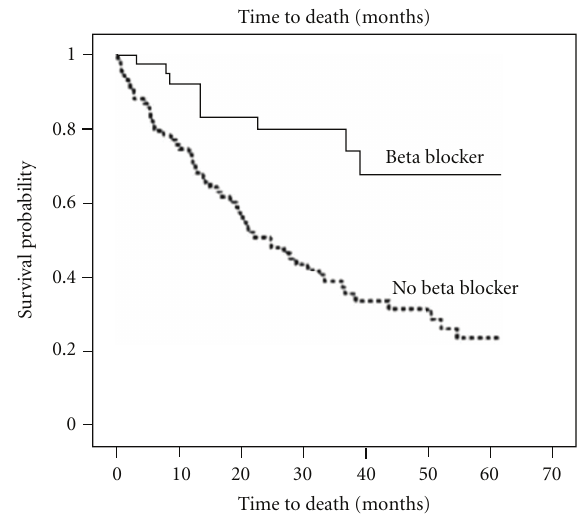
Figure 4: Survival probability according to use or no use of beta- adrenegic blockers. The probability of survival was significantly diminished in Chagasic patients who were not treated with beta- adrenegenic blockers. (see [43], adapted with permission from